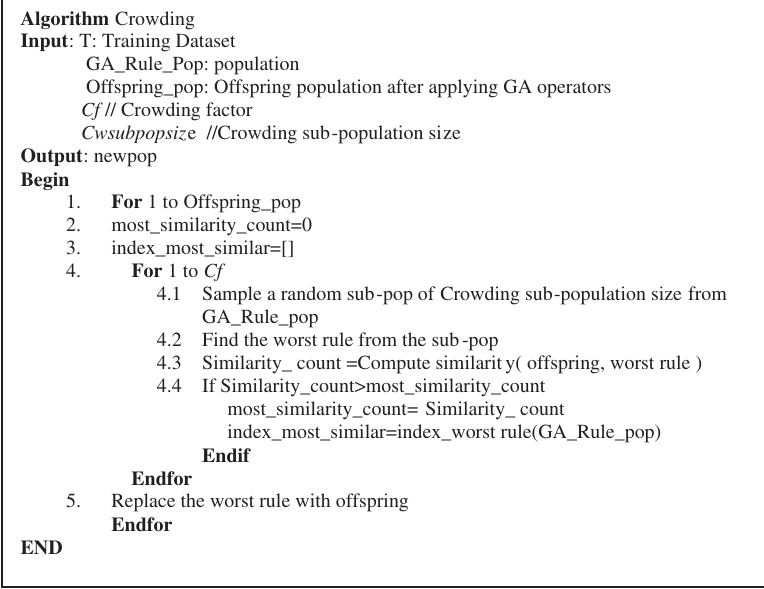
Algorithm Crowding Input : T: Training Dataset